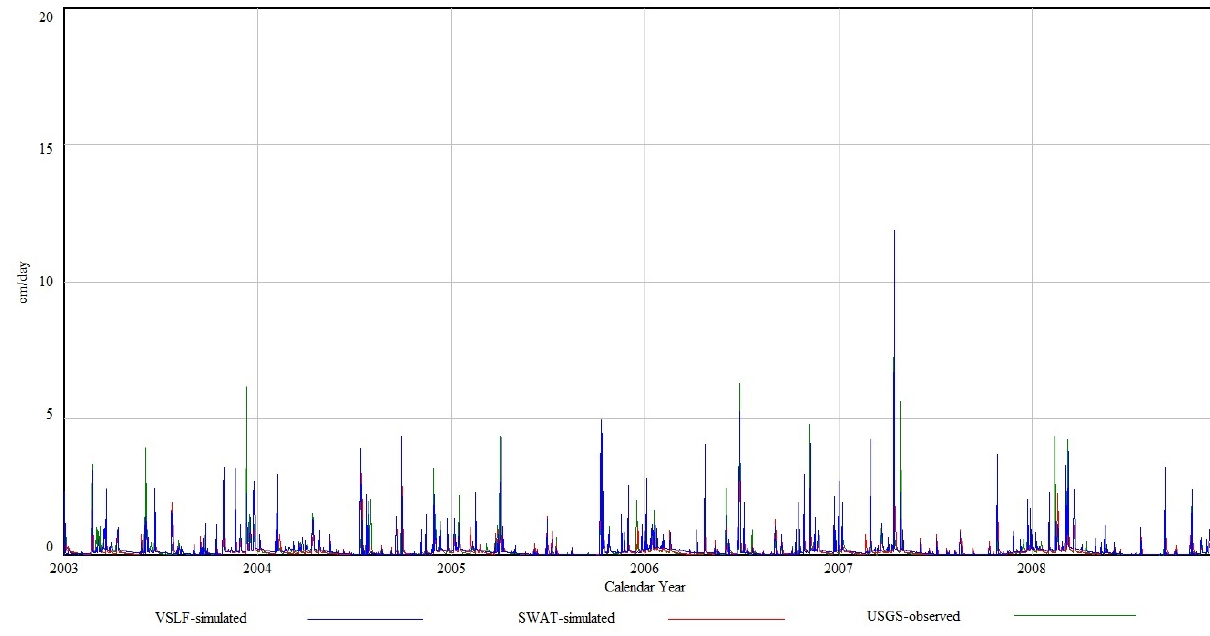
Figure 5. Comparison of VSLF- and SWAT-simulated and USGS-observed streamflow at the Reaville Gage Station in the Neshanic River